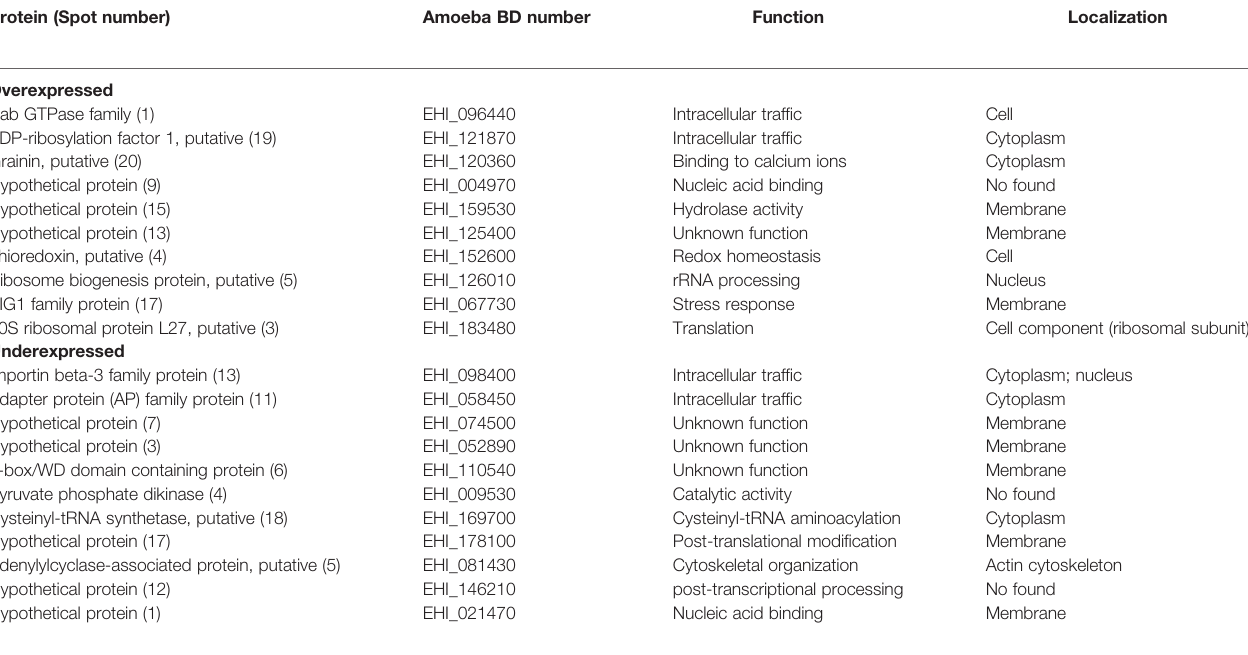
TABLE 4 | Functional categorization of E. histolytica proteins modulated by treatment with T-017. Protein (Spot